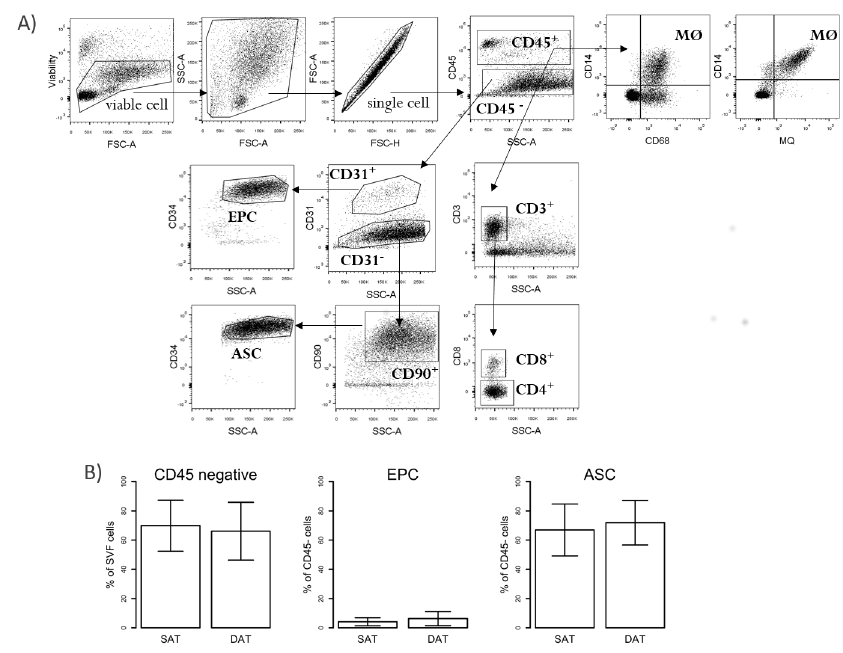
Figure 4. Flow cytometry analysis of ASC, endothelial progenitor cells (EPC), and T-cells in SVF from SAT, DAT, and blood. SVF cells isolated from SAT and DAT as well as peripheral blood mononuclear cells (PBMC) from paired samples were analysed by flow cytometry. ( A ) Representative FACS plots showing the gating strategy of different cell populations investigated in this study (FSC-A: forward scatter area; SSC-A: side scatter area; FSC-H: forward scatter height); ( B ) percentages of CD45 + and CD45 − are shown on viable cells. For further analysis, the percentages of cells were calculated based on CD45 + and CD45 − cells, respectively. EPC (CD45 − CD31 + CD34 + ) and ASC (CD45 − CD31 − CD90 + CD34 + ) are shown as percentage (%) of CD45 − cells. Results represent data from five patients and are expressed as mean ±